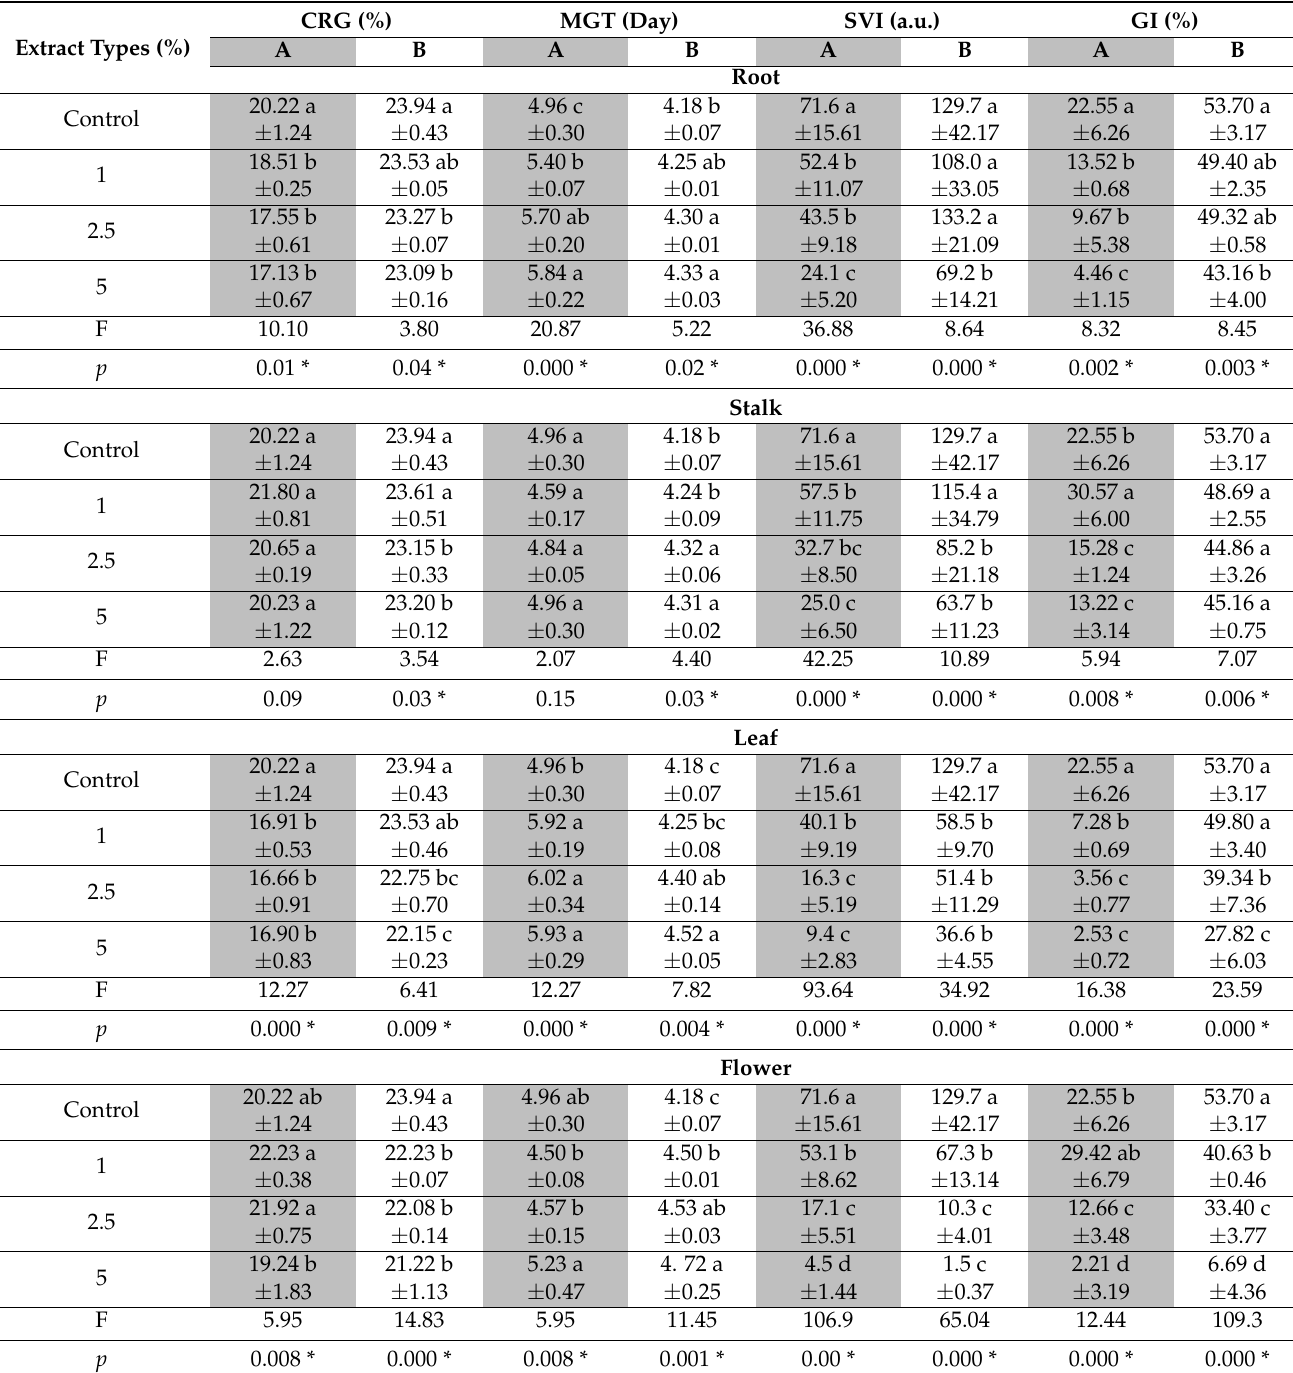
Table 1. Seed germination rates of Festuca rubra L. (A) and Raphanus sativus L. var. radicula Pers. cv. Rowa (B) seeds, treated with aqueous extracts from the organs of Rosa blanda Aiton with various concentrations (1%, 2.5%, 5%).